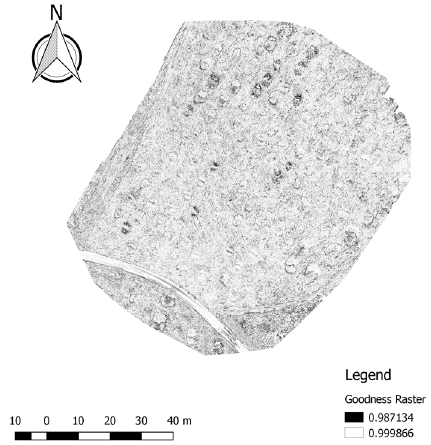
Figure 4. “Goodness for fit” map considering a thresholding of 0.65 and a minsize of 100, with separated